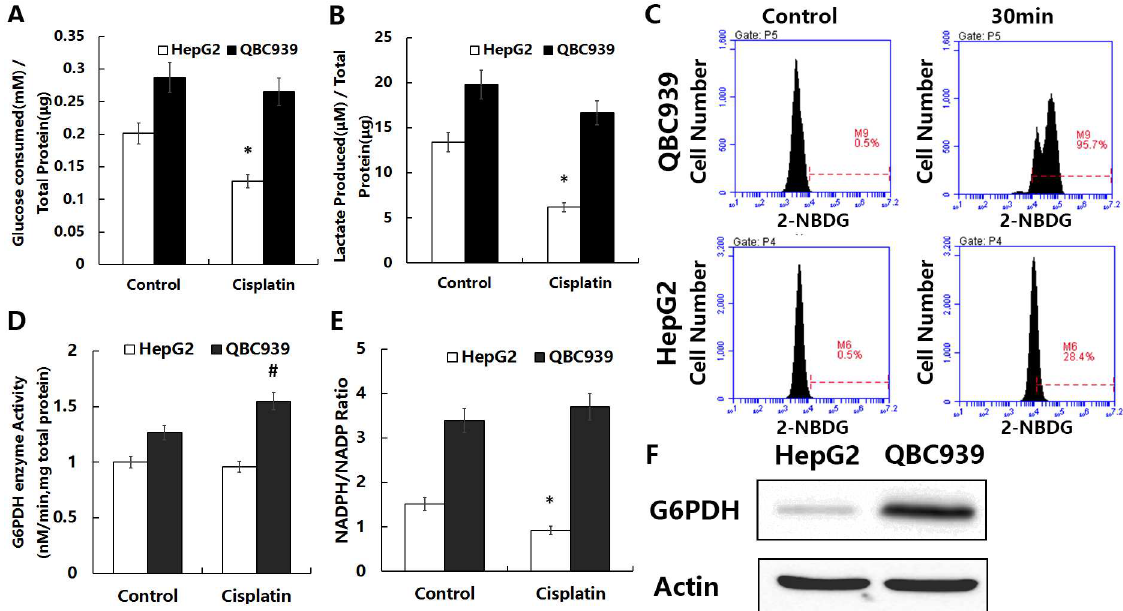
Fig 3. Enhancement of the glucose metabolism-derived antioxidant capacity in QBC939 cells. (A) Consumption of glucose in the medium, (B) production of lactic acid, (D) activity of G6PDH, and (E) ratio of NADPH/NADP after incubation under basal conditions or treated with cisplatin(20 μ g/ml) for 6 h. (C) Fluorescence intensity changeswere measuredafter incubation for 30 min with or without 50 μ M 2-NBDG using flow cytometry (x axis, fluorescence intensity; y axis, cell number). (F) Immunoblotanalysisof G6PDH expressionunder basal conditions. All values are the mean ± SE. * p < 0.05betweencontrol and other group in QBC939 cells, # p < 0.05betweencontrol and other group in HepG2 cells.